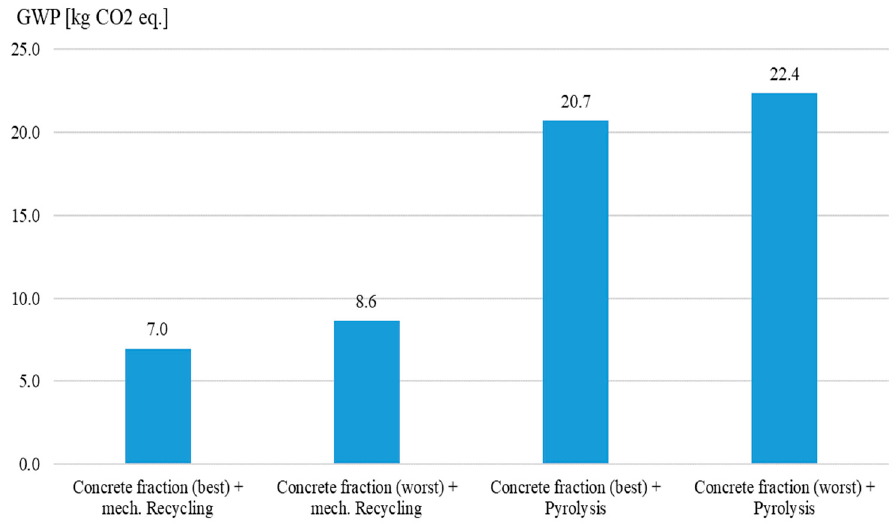
Figure 6. GWP per double wall CRC.